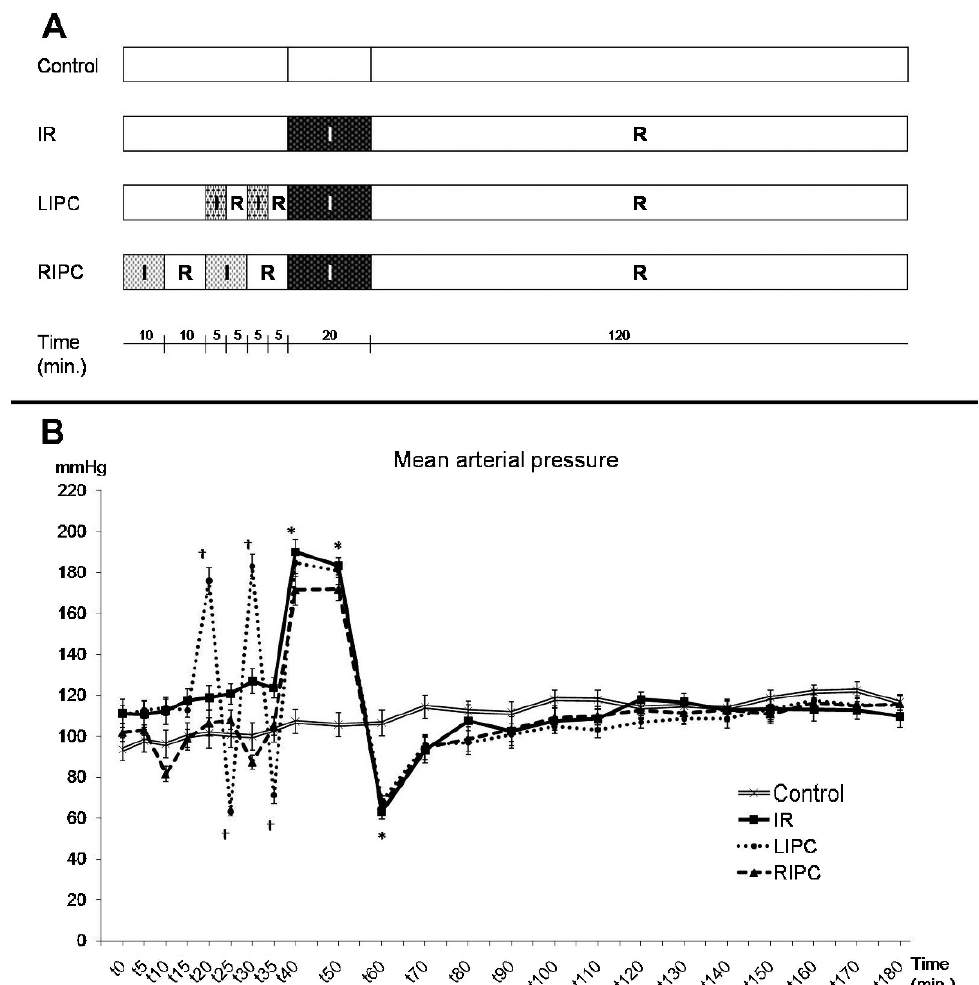
Figure 1 - Experimental protocol (A) and main arterial pressure variations during the experiment in the control, ischemia and reperfusion (IR), local ischemic preconditioning (LIPC), and remote ischemic preconditioning (RIPC) groups (B). Data are expressed as the mean ¡ SE for 7 animals per group. (*) p , 0.001: IR, LIPC, and RIPC vs . control, ( { ) p , 0.001: LIPC vs